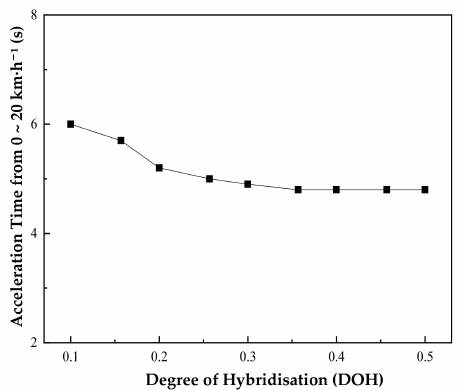
Figure 12. Curves of acceleration time with